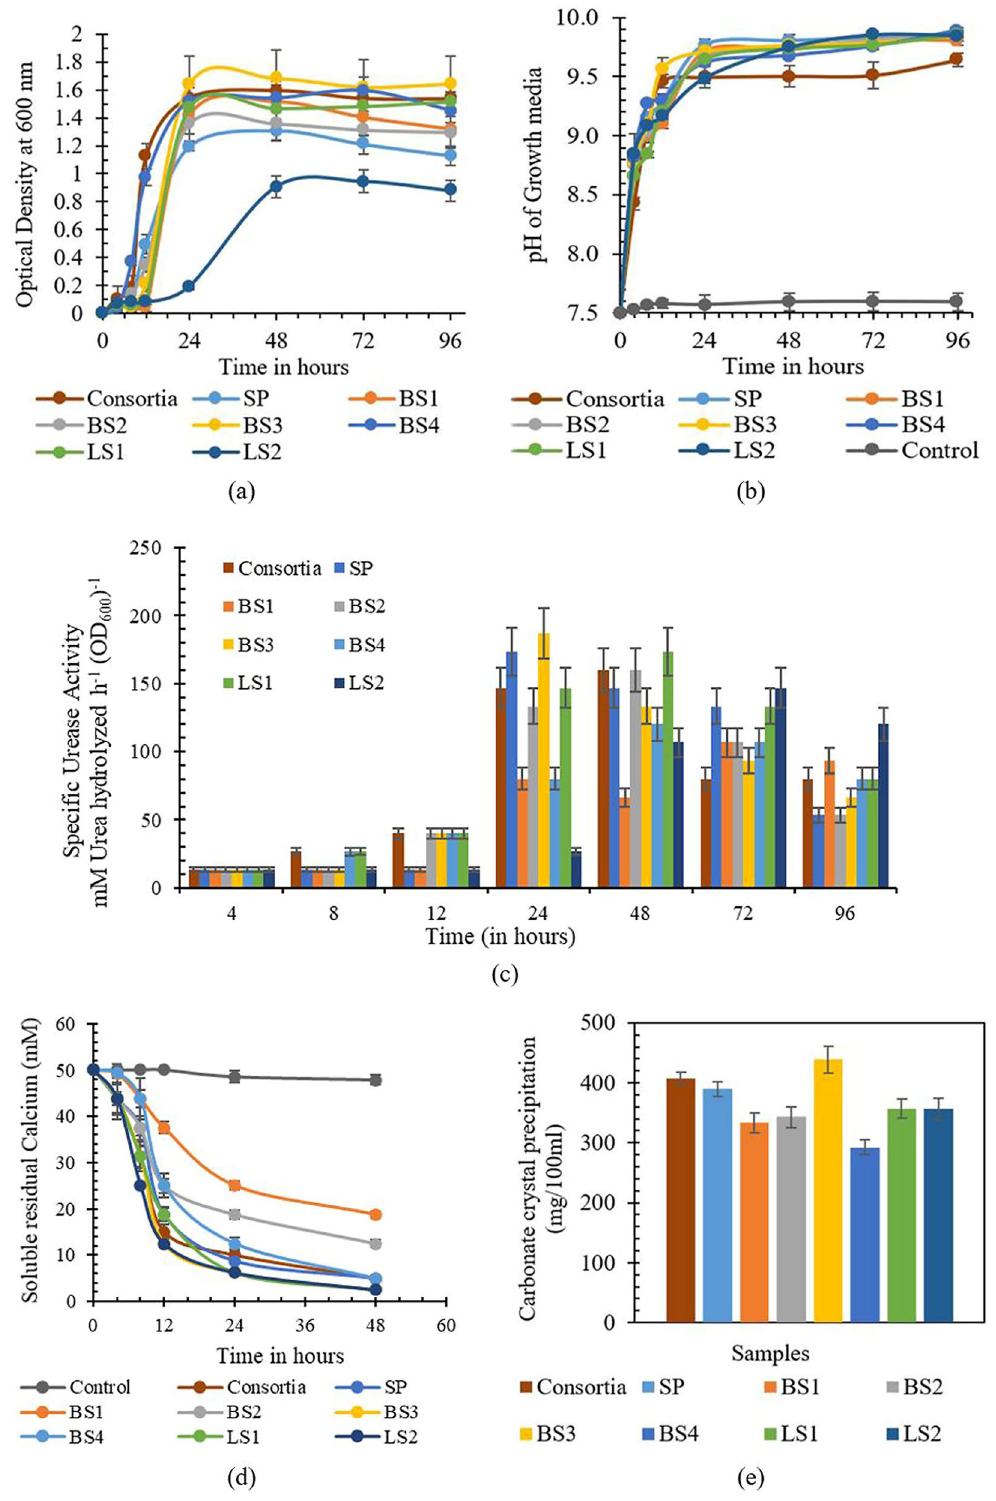
Figure 4. ( a ) Growth characteristics, ( b ) pH, ( c ) specific urease activity, ( d ) calcium utilization rate, and ( e ) carbonate precipitation rate of the isolates and